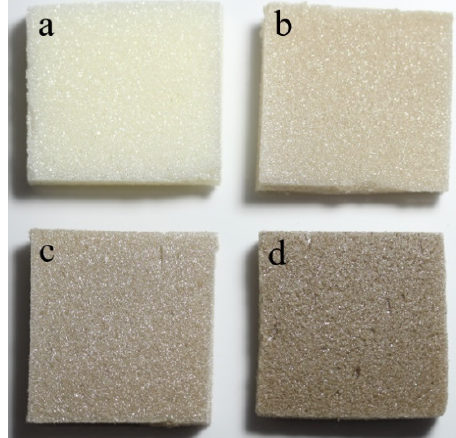
Figure 13. Photographs of synthesized polyurethane foams PUF0 ( a ), PUF1 ( b ), PUF2 ( c ), and PUF3 ( d ).